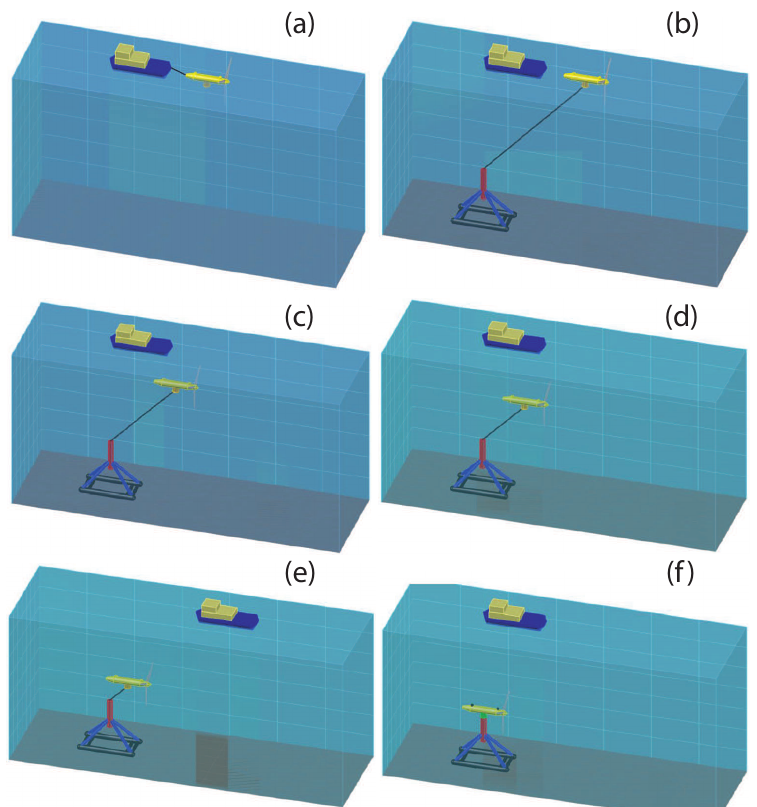
Figure 9. Automated installation maneuver of the gondola (immersion sequence): ( a ) movement of the device with maneuver control in closed loop; ( b ) connection between the cable wire and the gondola; ( c ) immersion maneuver in closed loop; ( d ) immersion maneuver in closed loop (cont.); ( e ) immersion maneuver finished; and ( f ) installation maneuver in closed loop